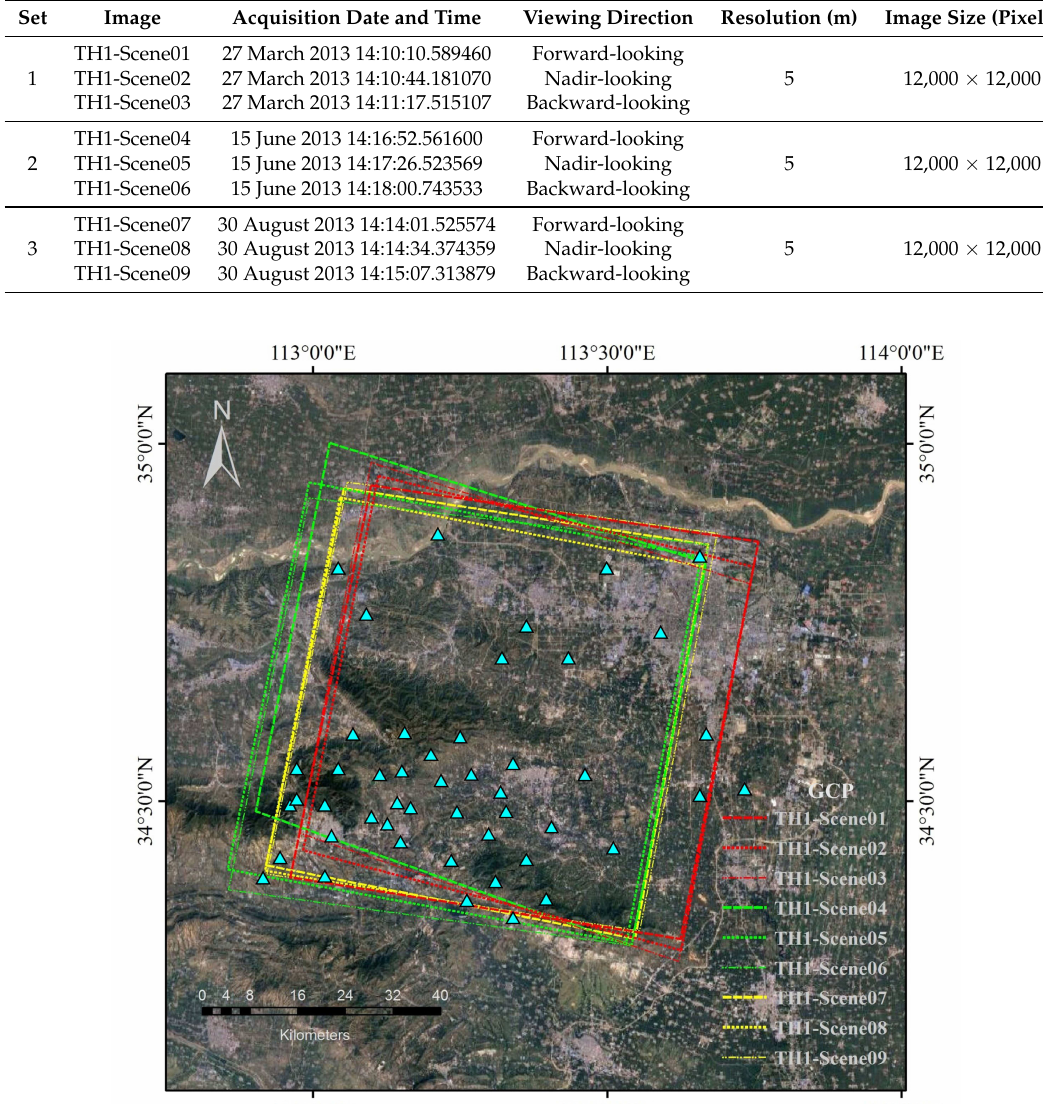
Table 4. Information of nine TH-1 images.